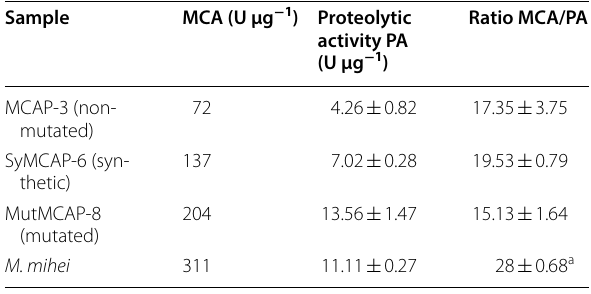
Table 4 Milk clotting and proteolytic activity of purified MCAP and its